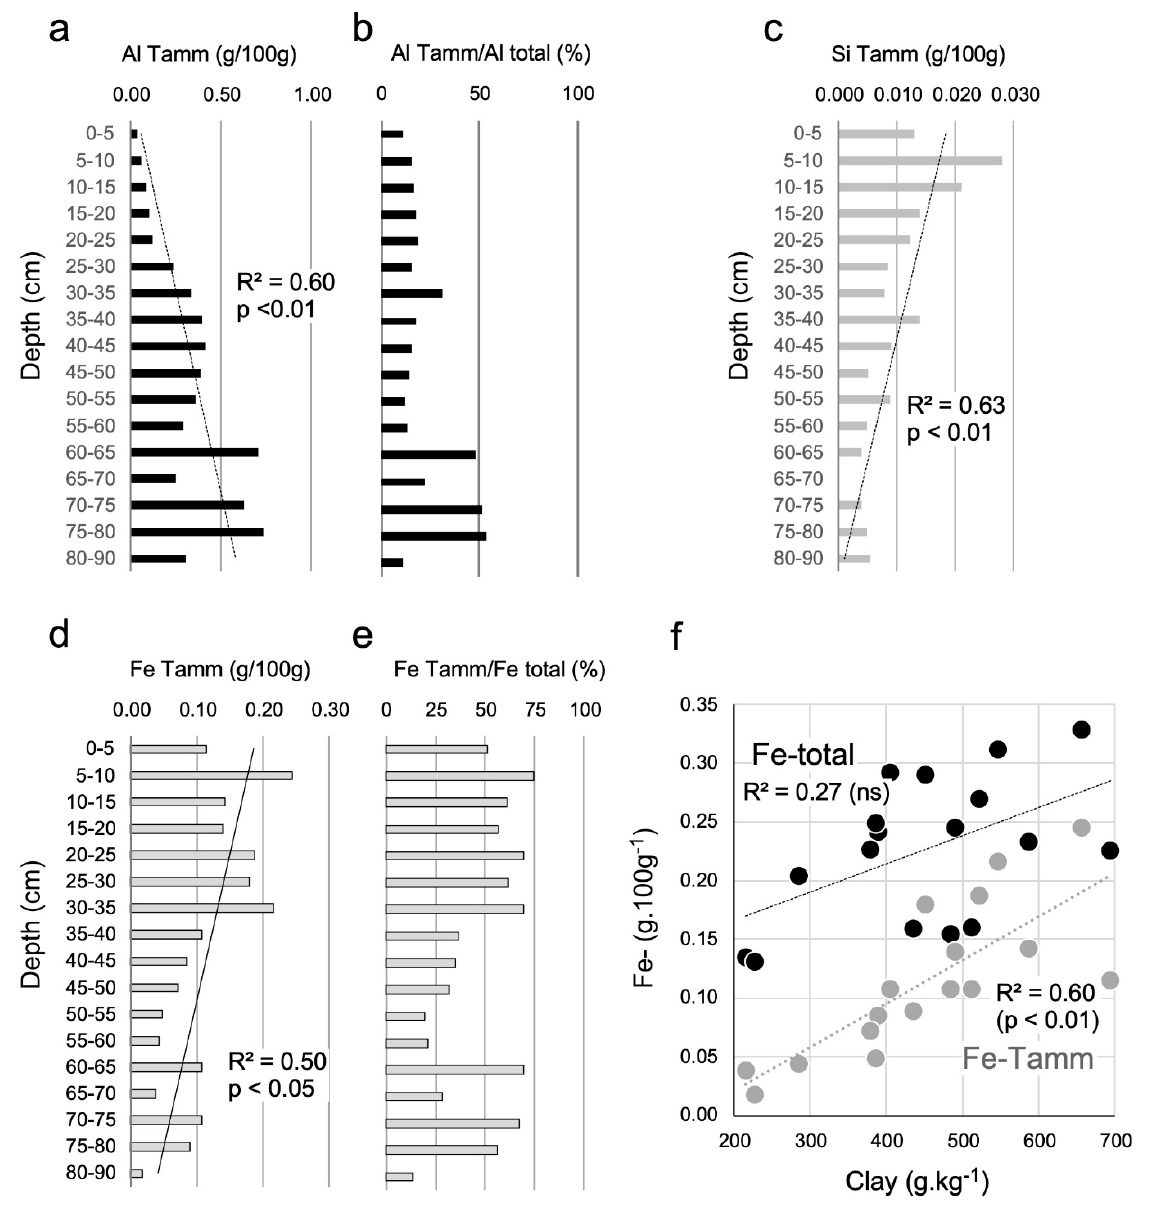
Figure 5. Aluminium ( a , b ), silicon ( c ) and iron ( d , e ) concentrations and amorphous:total ratios along the peat profile. For Al and Fe, the suffix -Tamm denotes the amorphous concentration ( a , d ). The ratio X-Tamm/X-total ( b , e ) reveals the contribution of the amorphous fraction of the metal (Al or Fe) to its total concentration (not shown). Concentrations of Fe-total and Fe-Tamm are plotted against the clay concentration ( f ) at the corresponding depth.